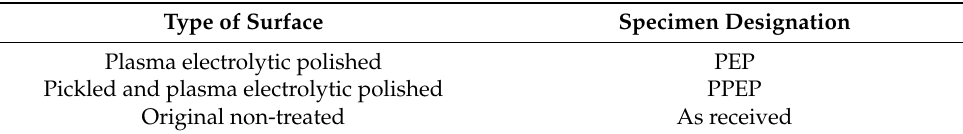
Table 3. Overview of tested surface conditions.